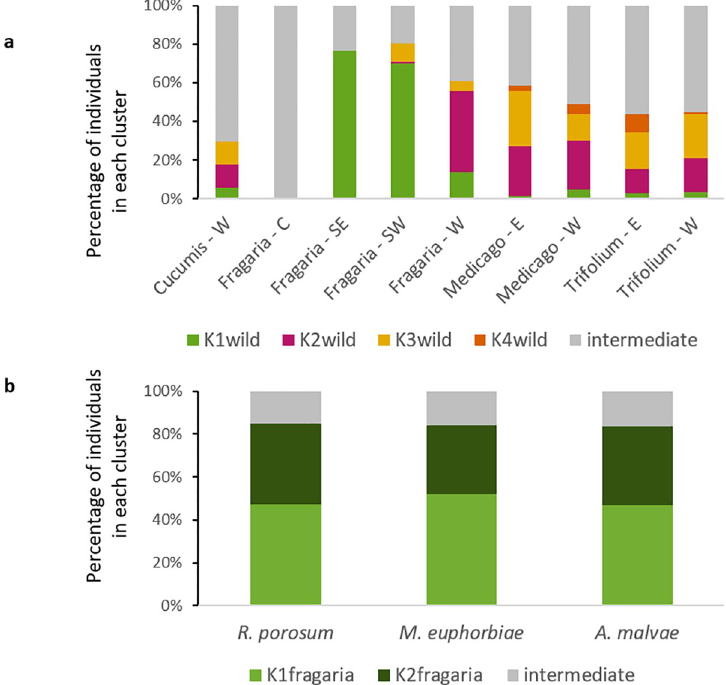
Fig 6. Percentage of individuals assigned in each cluster (with a threshold of coefficient of ancestry Q > 0.8) using Bayesian clustering with the program STRUCTURE. (a) ‘wild’ individuals according to the host plant and the region of sampling with four clusters. (b) ‘wild’ individuals from strawberry greenhouses according to the aphid host with two clusters. W: ‘West’; SW: ‘Southwest’; C: ‘Center’; E: ‘East’; SE: ‘Southeast’.